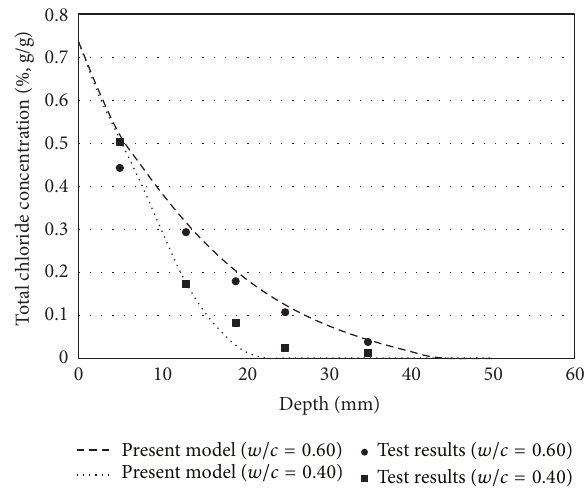
Figure 9: A comparison between numerical results and experimen- tal